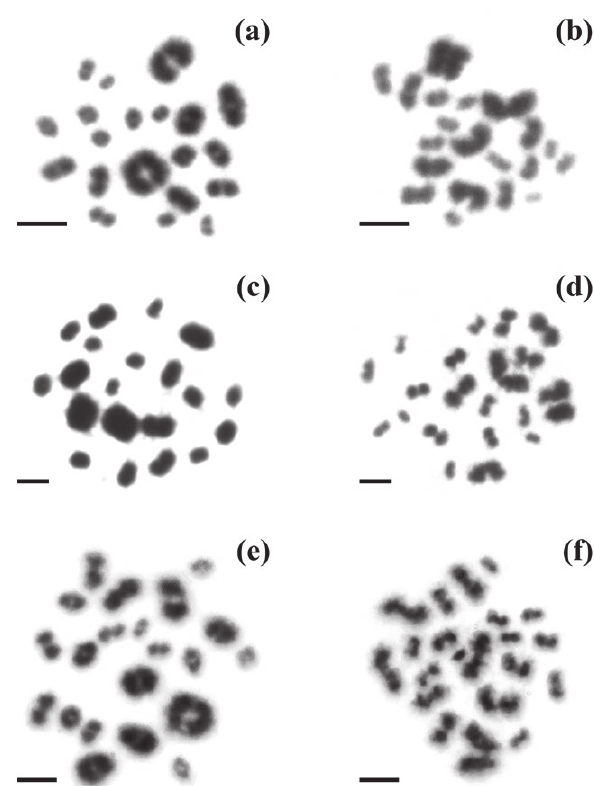
Figure 5. Respective bivalent on metaphase I and haploid chromo- some on metaphase II of male D. hangseesom (20 bivalents, a; 20 haploid chromosomes, b), male D. siamensis (20 bivalents, c; 20 haploid chromosomes, d) and male D. melanostictus (21 bivalents, e; 21 haploid chromosomes, f). Scale bars indicate 5